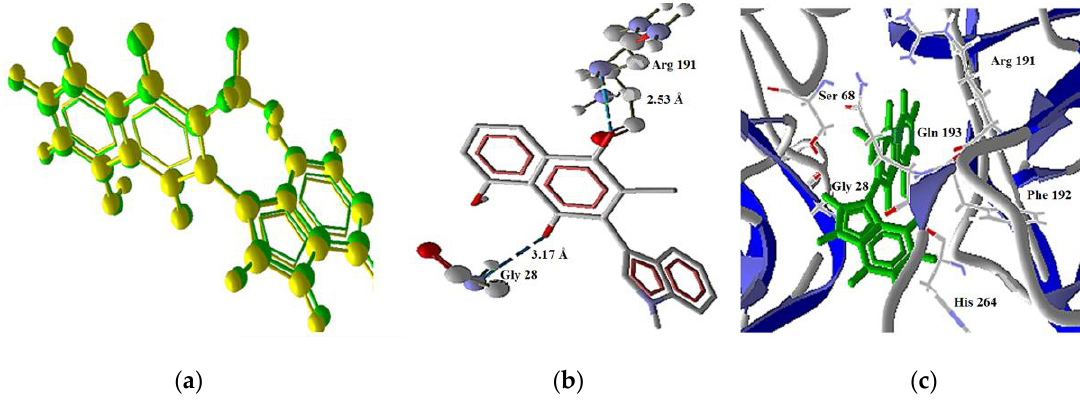
Figure 12. Model of the interaction of 3 with TRIAL-2 (4N90 isoform). ( a ) Compound 3 and TRIAL-2 complex, overlapping of the ligand (green) and the pose (yellow); ( b ) Interaction of 3 and TRIAL-2 complex, showing three H bonds with protein residues; ( c ) Secondary structure, ligand (green) in the middle of the two protein isomers.